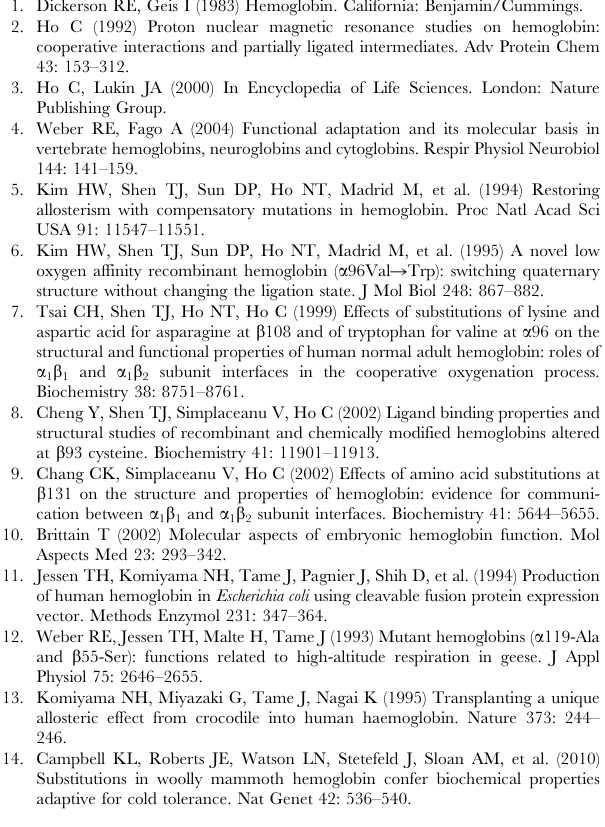
Table S1 Table showing in silco predictions of the intrinsic solubilities of hemoglobins from a phylogenet- ically diverse set of vertebrate